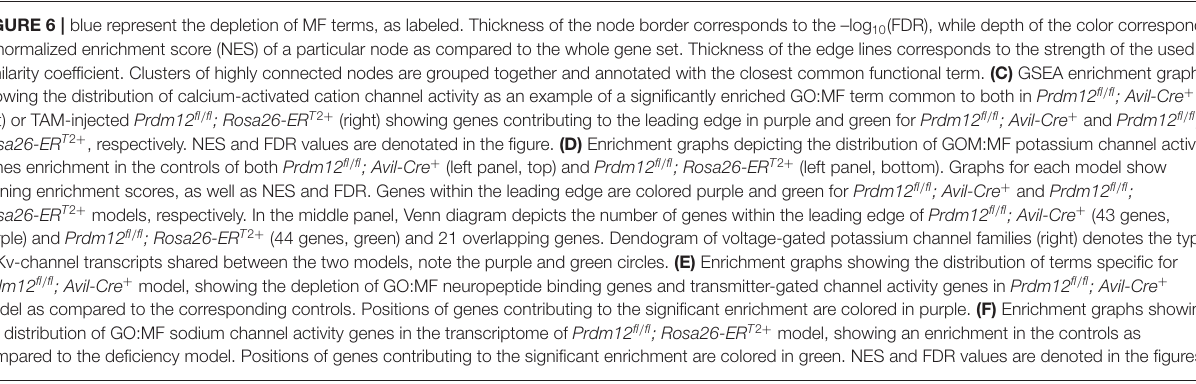
FIGURE 6 | blue represent the depletion of MF terms, as labeled. Thickness of the node border corresponds to the –log 10 (FDR), while depth of the color corresponds to normalized enrichment score (NES) of a particular node as compared to the whole gene set. Thickness of the edge lines corresponds to the strength of the used similarity coefficient. Clusters of highly connected nodes are grouped together and annotated with the closest common functional term. (C) GSEA enrichment graphs showing the distribution of calcium-activated cation channel activity as an example of a significantly enriched GO:MF term common to both in Prdm12 fl / fl ; Avil-Cre + (left) or TAM-injected Prdm12 fl / fl ; Rosa26-ER T 2 + (right) showing genes contributing to the leading edge in purple and green for Prdm12 fl / fl ; Avil-Cre + and Prdm12 fl / fl ; Rosa26-ER T 2 + , respectively. NES and FDR values are denotated in the figure. (D) Enrichment graphs depicting the distribution of GOM:MF potassium channel activity genes enrichment in the controls of both Prdm12 fl / fl ; Avil-Cre + (left panel, top) and Prdm12 fl / fl ; Rosa26-ER T 2 + (left panel, bottom). Graphs for each model show running enrichment scores, as well as NES and FDR. Genes within the leading edge are colored purple and green for Prdm12 fl / fl ; Avil-Cre + and Prdm12 fl / fl ; Rosa26-ER T 2 + models, respectively. In the middle panel, Venn diagram depicts the number of genes within the leading edge of Prdm12 fl / fl ; Avil-Cre + (43 genes, purple) and Prdm12 fl / fl ; Rosa26-ER T 2 + (44 genes, green) and 21 overlapping genes. Dendogram of voltage-gated potassium channel families (right) denotes the type of Kv-channel transcripts shared between the two models, note the purple and green circles. (E) Enrichment graphs showing the distribution of terms specific for Prdm12 fl / fl ; Avil-Cre + model, showing the depletion of GO:MF neuropeptide binding genes and transmitter-gated channel activity genes in Prdm12 fl / fl ; Avil-Cre + model as compared to the corresponding controls. Positions of genes contributing to the significant enrichment are colored in purple. (F) Enrichment graphs showing the distribution of GO:MF sodium channel activity genes in the transcriptome of Prdm12 fl / fl ; Rosa26-ER T 2 + model, showing an enrichment in the controls as compared to the deficiency model. Positions of genes contributing to the significant enrichment are colored in green. NES and FDR values are denoted in the